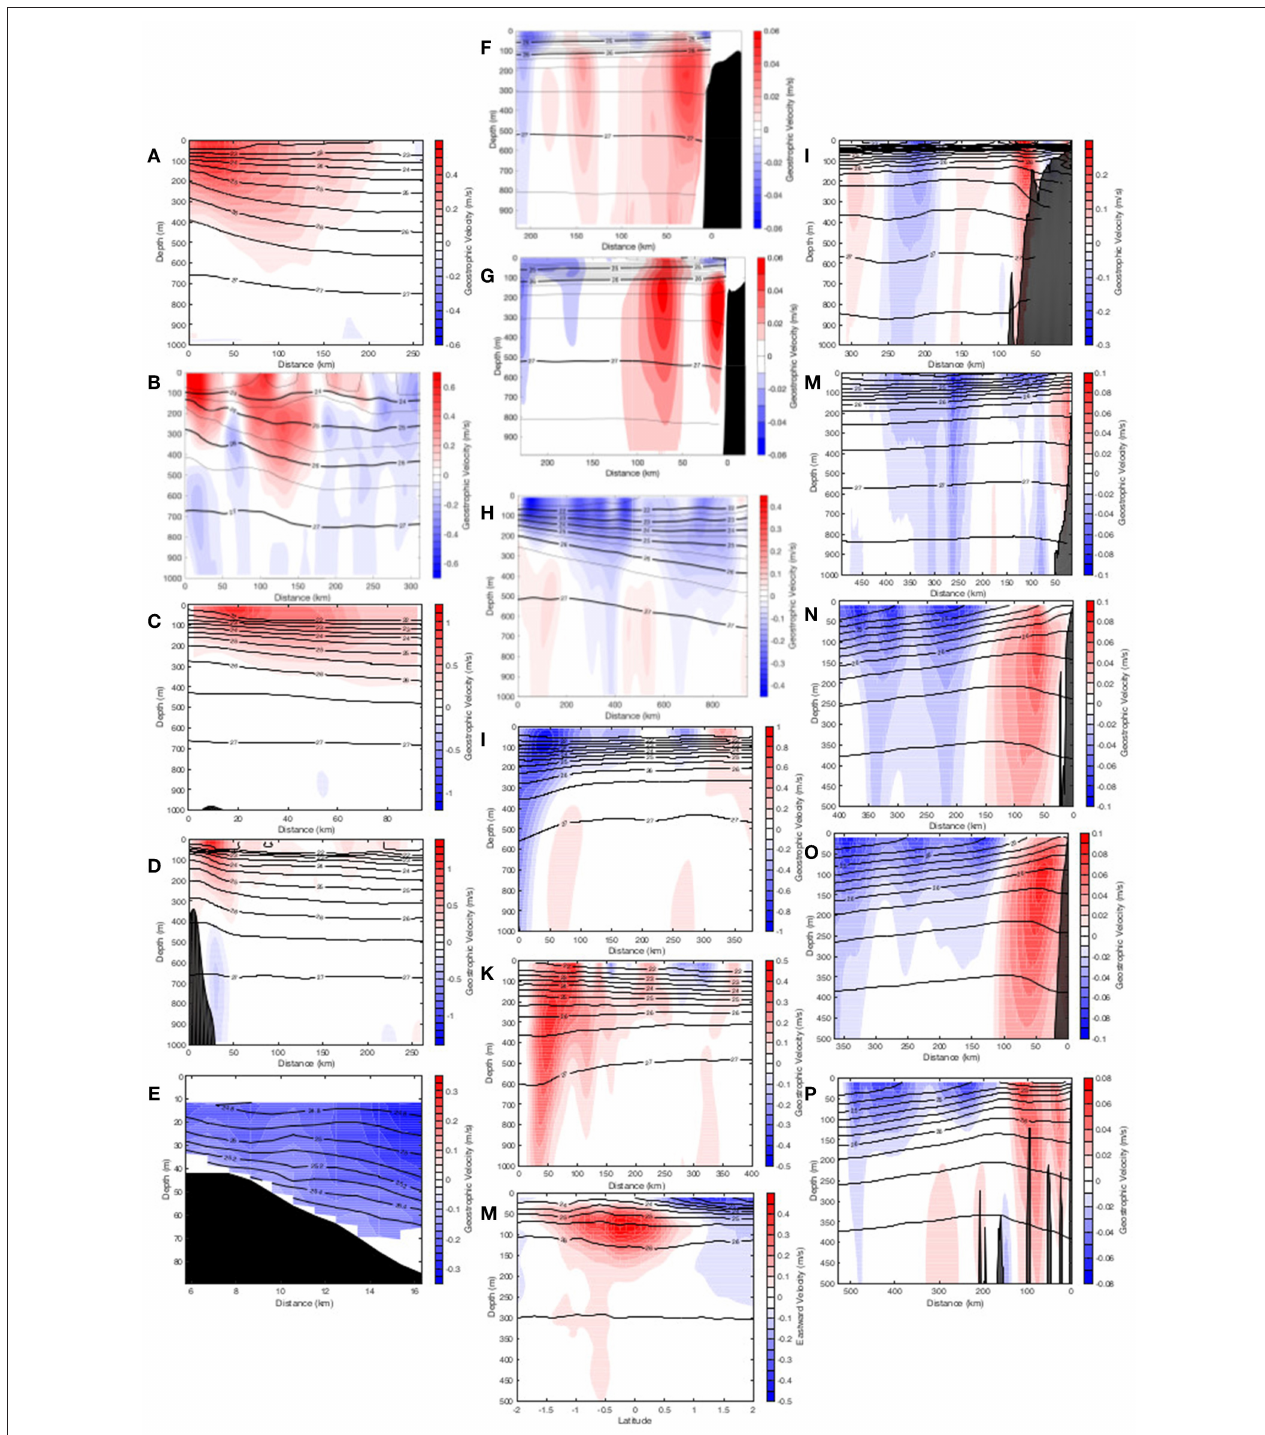
FIGURE 6 | Mean sections of geostrophic velocity from the Pacific. Sections in the western Pacific include the Kuroshio offshore of (A,B) Taiwan and (C,D) Luzon, and in (E) the East Australian Current, (H) the North Equatorial Current, (I) the Mindanao Current, and (J) the New Guinea Coastal Current of the Solomon Sea. Sections in the eastern Pacific include (F,G) two off Washington, (L) one off Oregon and four off the California coast at (M) Trinidad Head, (N) Monterey Bay, (O) Point Conception, and (P) Dana Point. A mean section across the equator at 93 ◦ W off the Galapagos (K) was measured by acoustic Doppler profilers, as geostrophy fails at the equator. The sections are oriented generally west to east or south to north, and positive velocity is primarily northward or eastward.